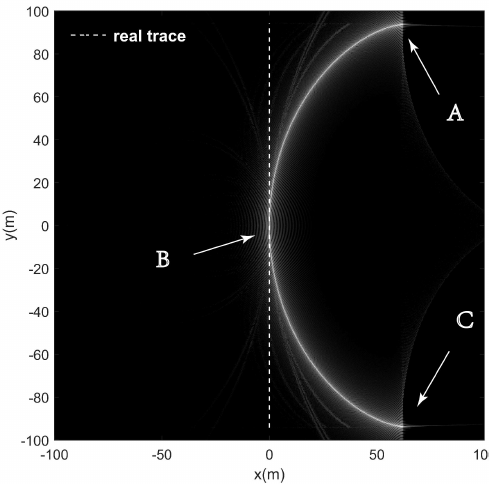
Figure 10. Target’s real trace and moving target SAR image. The target moved at 4 m/s along the dashed line from bottom to top.